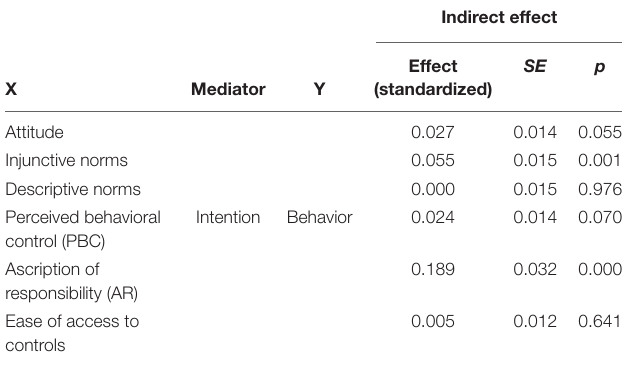
TABLE 4 | Indirect effects on Behavior for single-person